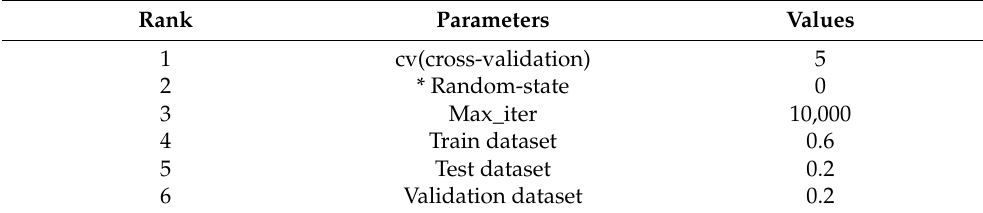
Table 6. The parameters of training model.